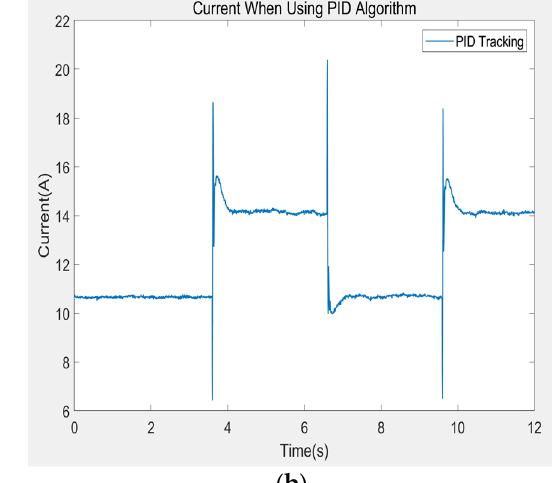
( b ) Figure 21. Gap and current value under SMC control algorithm: ( a ) Gap value; ( b ) current value. ( a ) ( b ) Figure 22. Gap and current value under LESOSMC control algorithm: ( a ) Gap value; ( b ) current value.